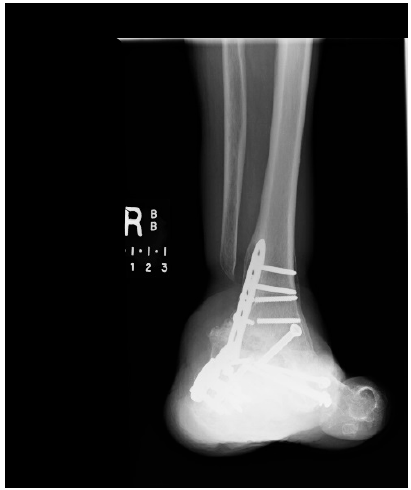
Figure A5. 5 years post-op with additional fractures in a 3.5 mm cortical screw in the tibia, a second 3.5 mm talonavicular screw, the 6.5 mm cannulated screw, and the 3.5 mm LCP plate.